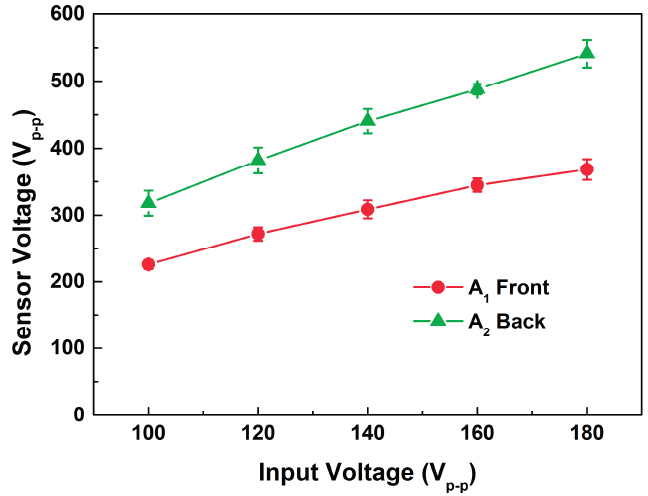
Figure 8. Sensor voltages of sensor locations A 1 and A 2 .